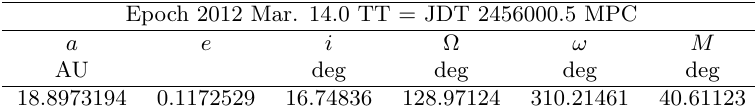
Fig. 1. Discovery image of 2012 DS85. The size of the field is 2.3 ′ (cid:2) 2.7 ′ , the exposure time 6 min. Exposed with the VATT on Mt. Graham in the evening of 2012 February 19. Two Main Belt asteroids (2012 BR72 and CB 12141) and the TNO 2012 BX85 (discovered by our team on January 5) are also identified. Table 2. Nominal orbit of 2012 DS85 from the MPO